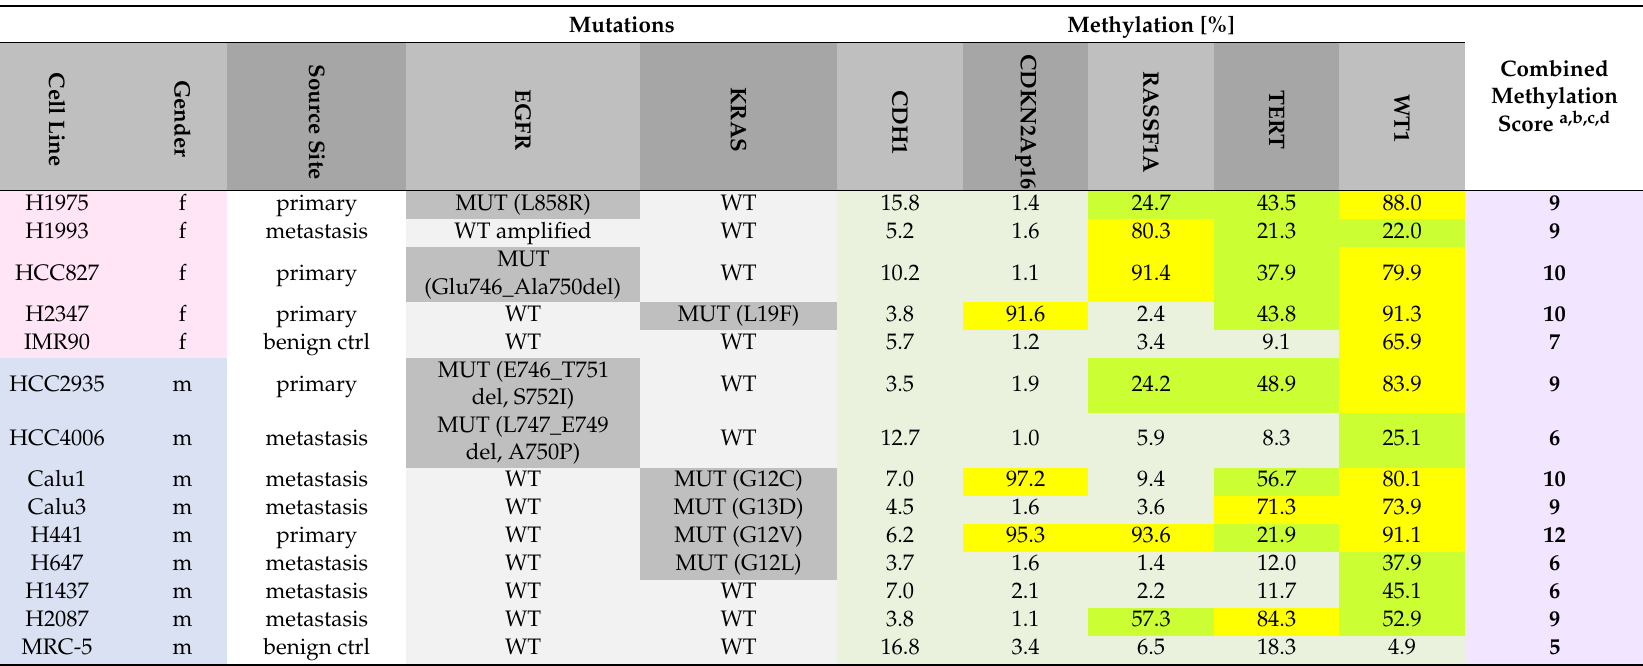
Table 2. Cell lines with the relevant information on gender, EGFR , and KRAS mutational status, as well as methylation levels for CDH1. CDKN2Ap16. RASSF1A, TERT , and WT1 . f—female (pink shading); m—male (blue shading); MUT—mutated (dark grey); WT—wildtype (light grey); methylation levels under 21 % were scored as low—light green shading, those between 21 % and 59 % as medium—bright green shading, and levels above 59 % as high—yellow shading. Mutations Methylation [%]